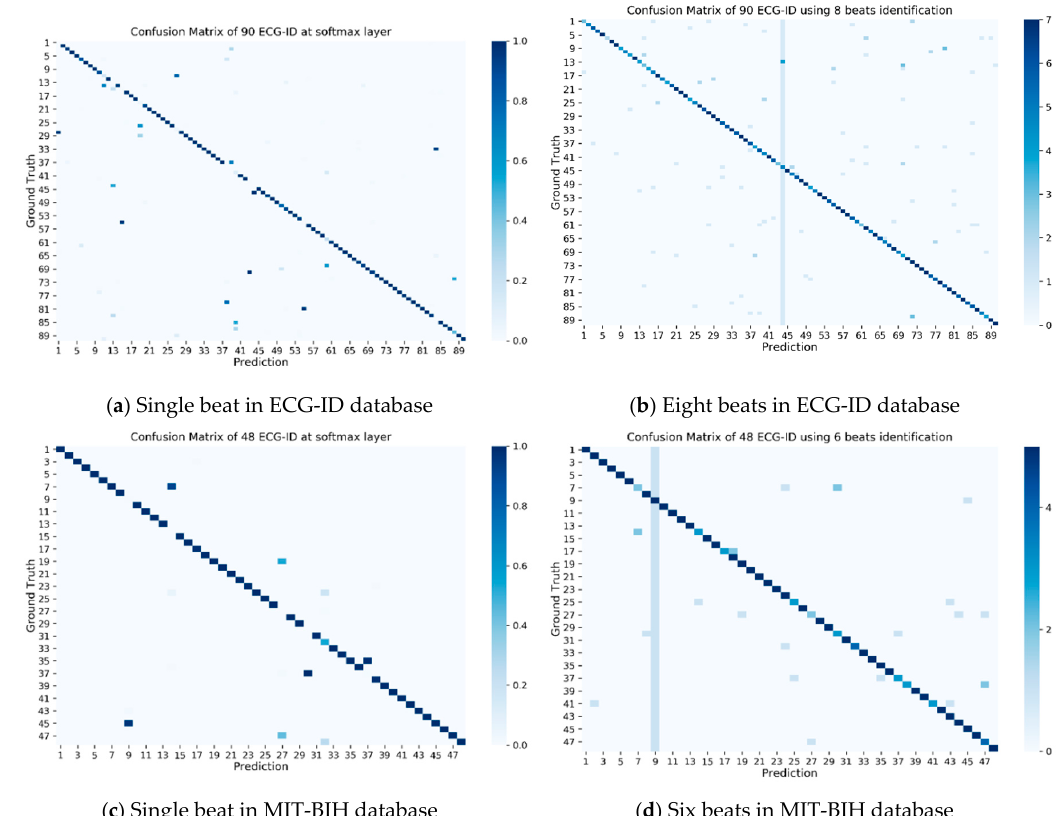
Figure 5. Confusion matrix of the softmax layer (output layer) using single and multiple ECG beats for ECG-ID and MIT-BIH databases.